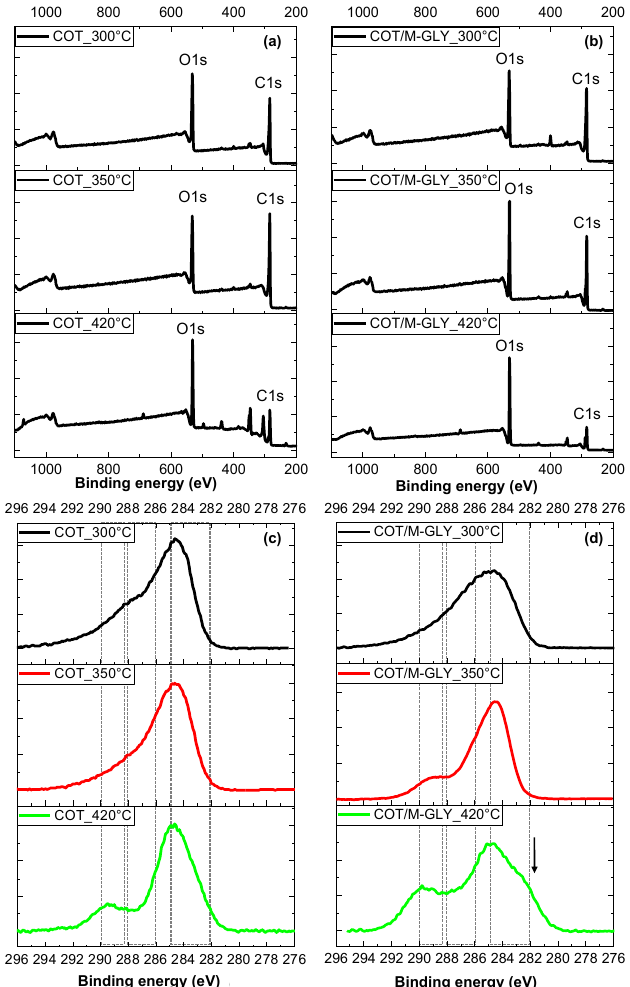
Figure 6. XPS spectra of untreated cotton (COT) ( a ) and 4% add ‐ on M ‐ GLY ‐ treated cotton (COT/M ‐ GLY) ( b ) residues heated at 300 °C, 350 °C and 420 °C. Expansion of C 1s band in the 276–296 eV region for COT ( c ) and COT/M ‐ GLY ( d ) residues heated to 300 °C, 350 °C and 420 °C.